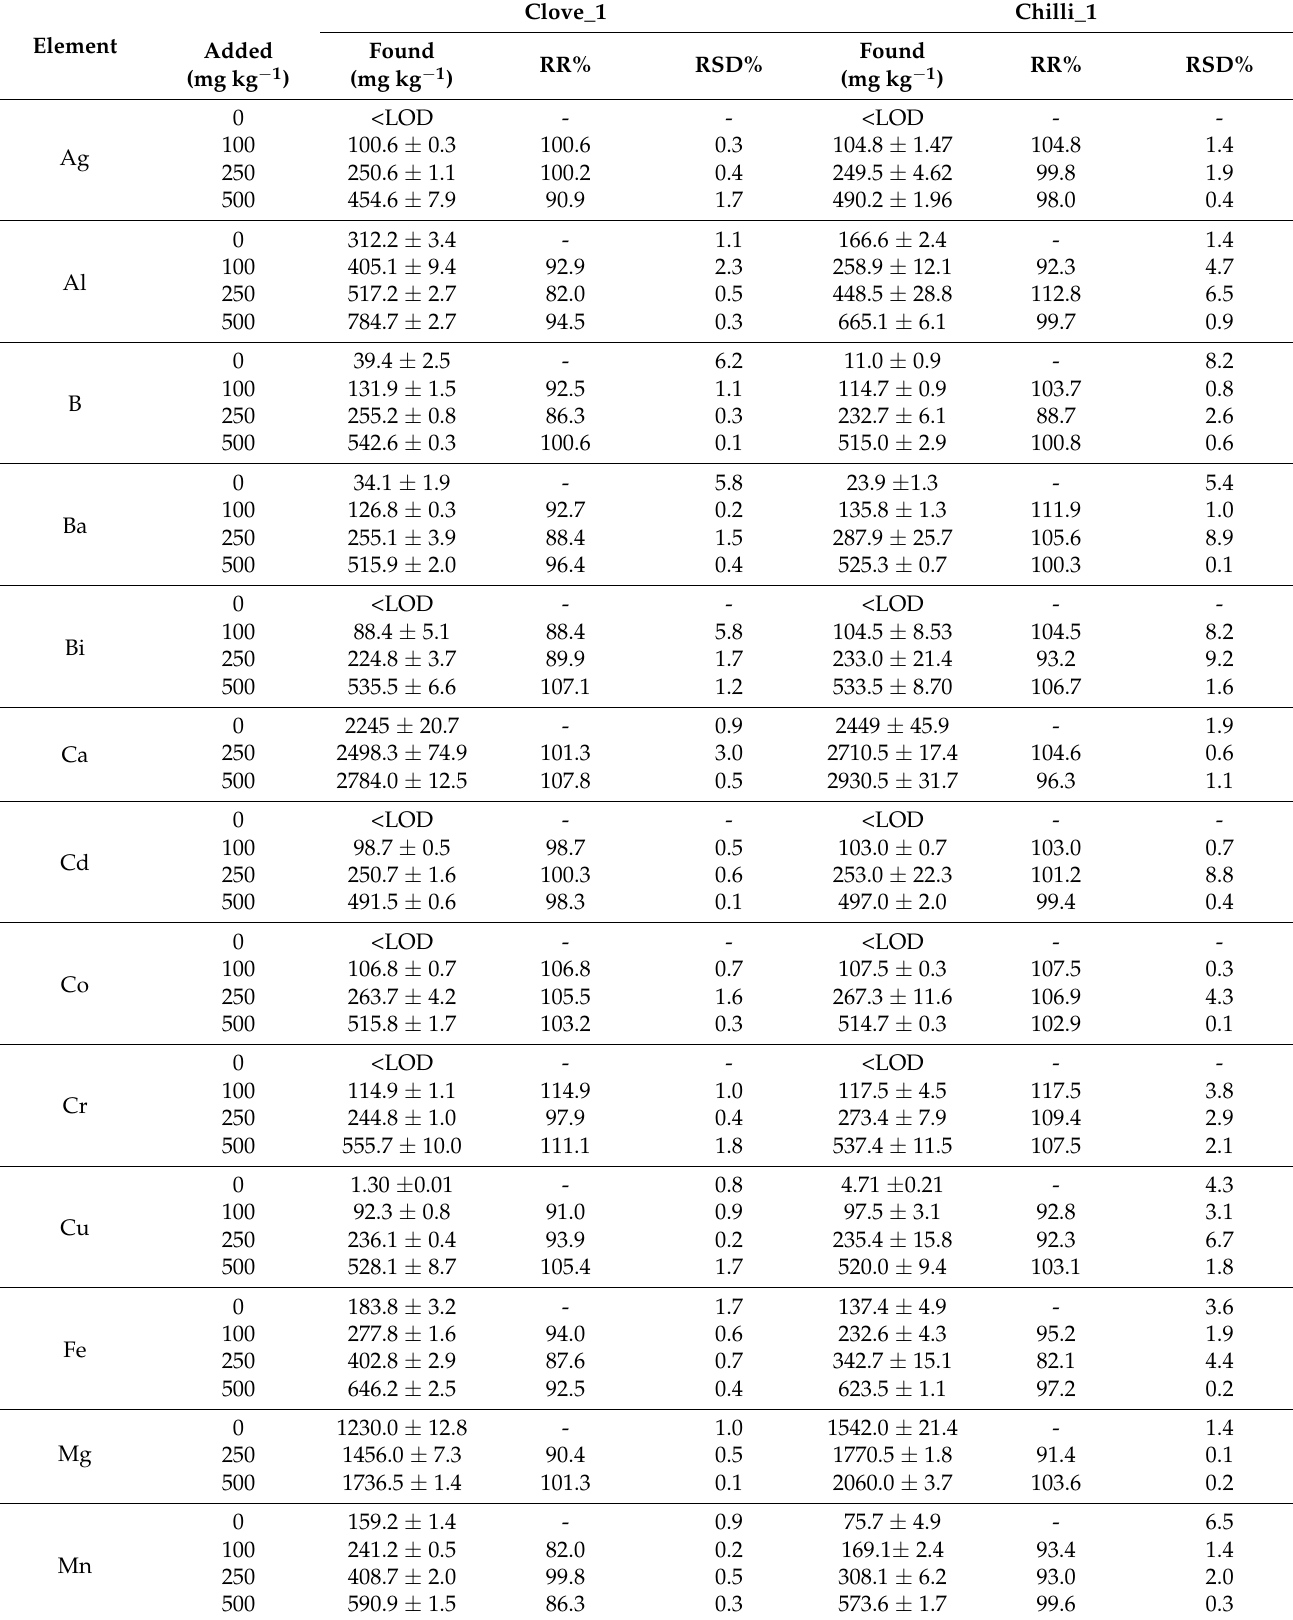
Table 2. Trueness and precision study for the examined analytes (mean value ± standard